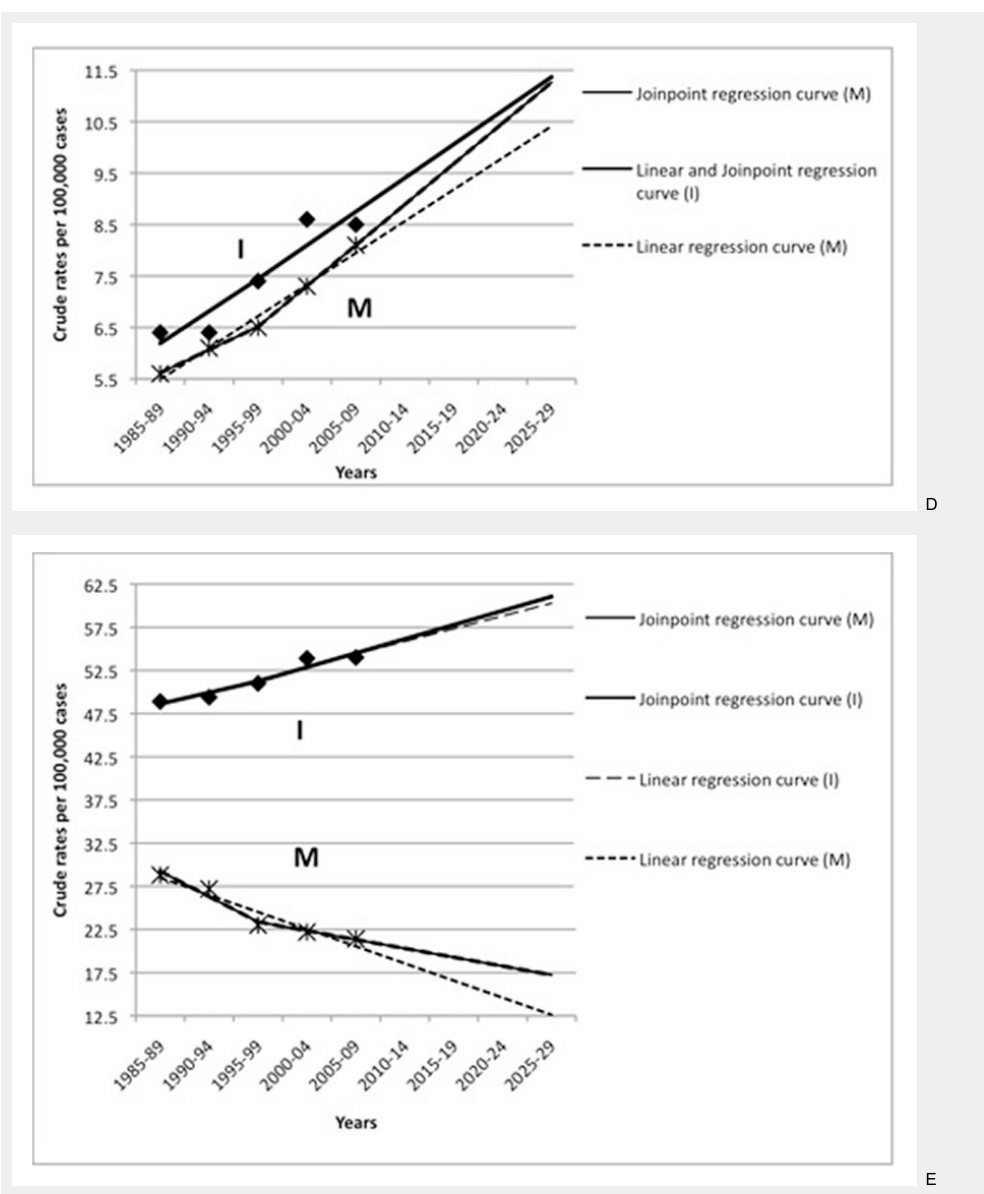
Figure 1 Crude incidence (I, diamonds represent the figures extracted from STAT-TAB) and mortality (M, asterisks represent the figures extracted from STAT-TAB) rates (median per year per 100 000 inhabitants) from 1985‒89 to 2025‒2029 in Switzerland with linear and Joinpoint regression models. A Oesophageal cancer B Gastric cancer C Pancreatic cancer D Liver cancer E Colorectal